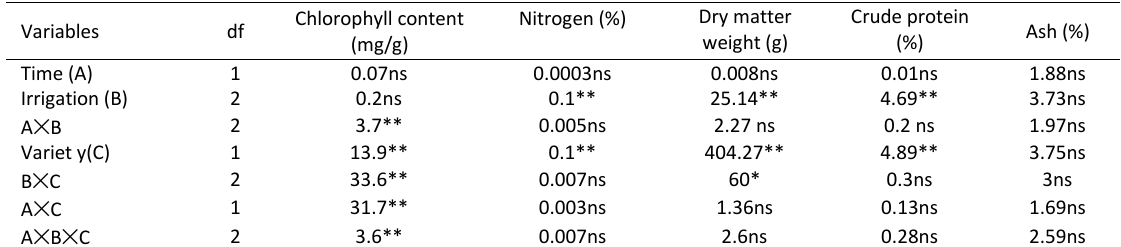
Table 2: Two-way ANOVA results of variables of the two varieties of sorghum at different years under different irrigation levels Variables df